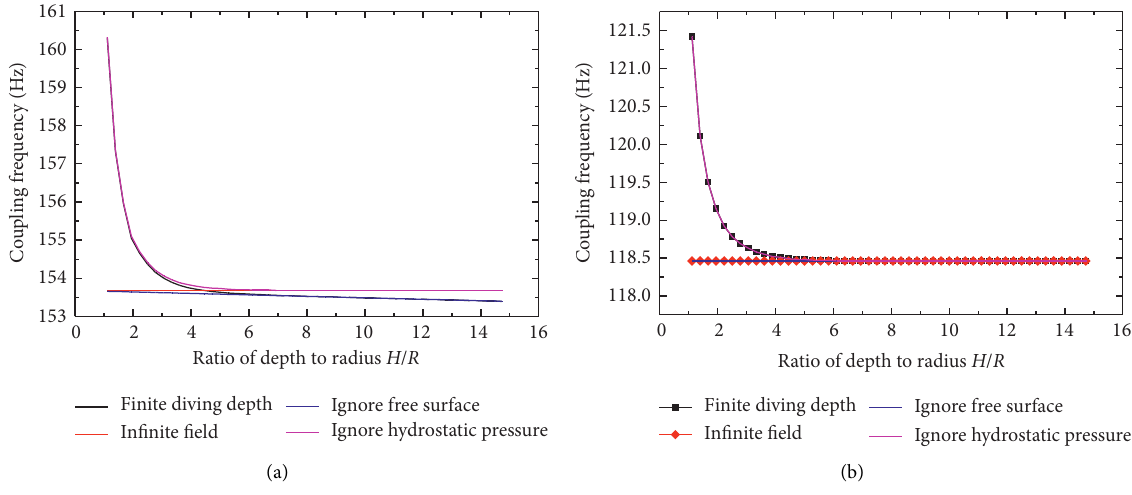
Figure 9: Coupling frequency curves of different diving depths. (a) Underwater immersion. (b) Water immersion on both